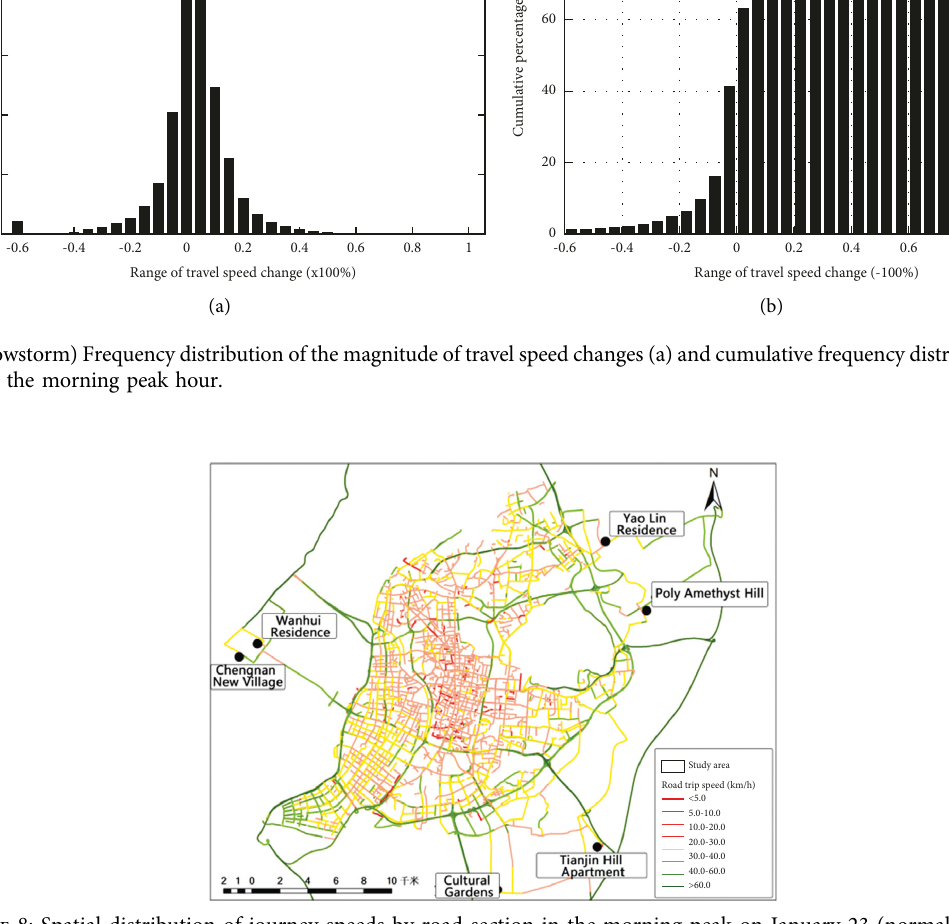
Figure 8: Spatial distribution of journey speeds by road section in the morning peak on January 23 (normal